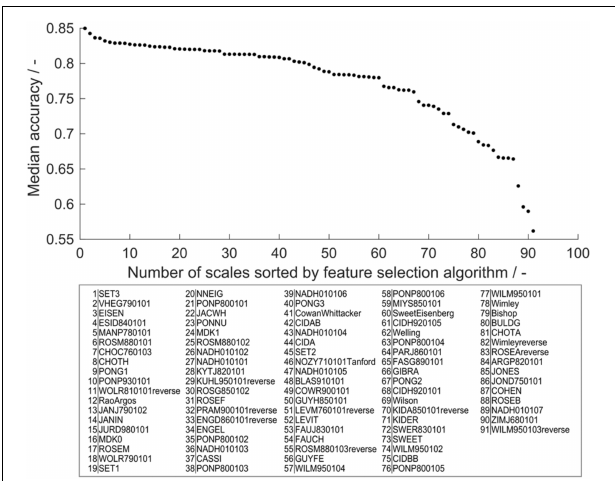
FIGURE 6 | Median feature importance measured by the median training set accuracy of the individual scales in all 190 × 91 models in the learning experiment. Median accuracy of scales was sorted in descending order, so that scale 1 has highest accuracy and therefore highest feature importance, while scale 91 has lowest feature importance. The IDs of the scales (i.e., feature names) are noted below in respective